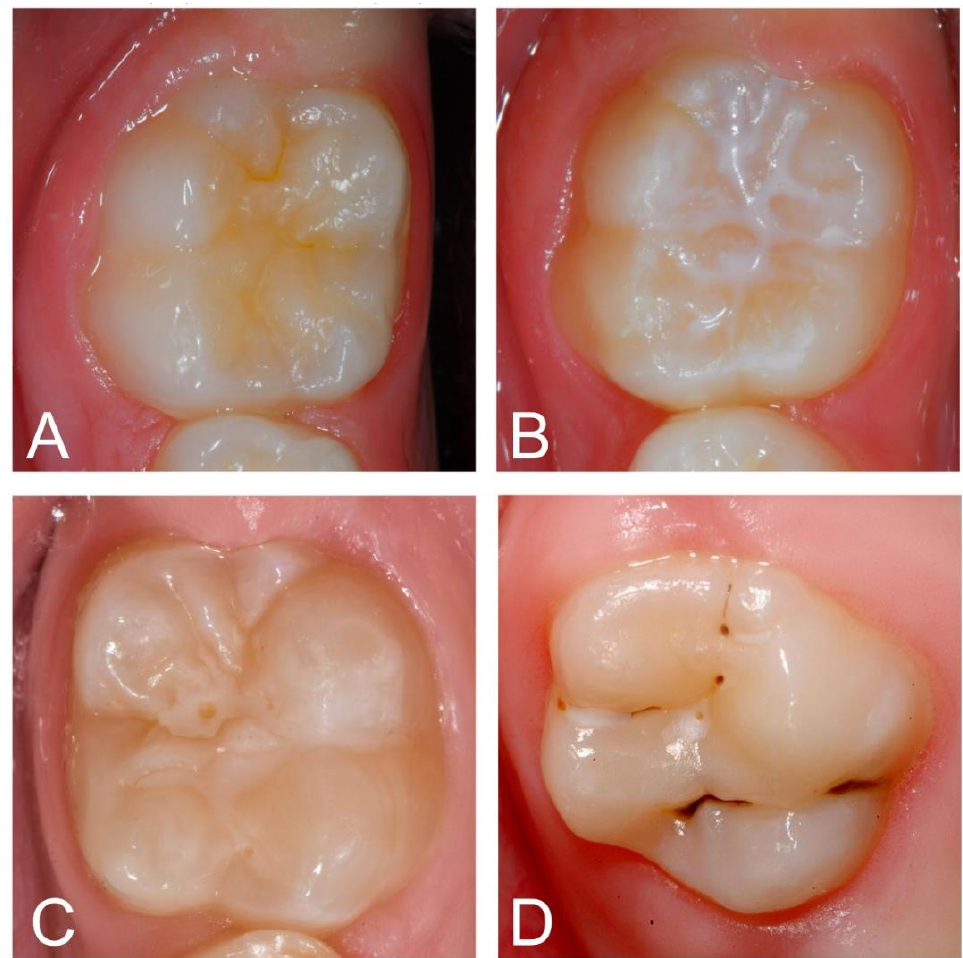
Figure 1. Example clinical images for each category: unsealed molar (A) and intact (B), sufficient (C) and insufficient fissure sealant (D).